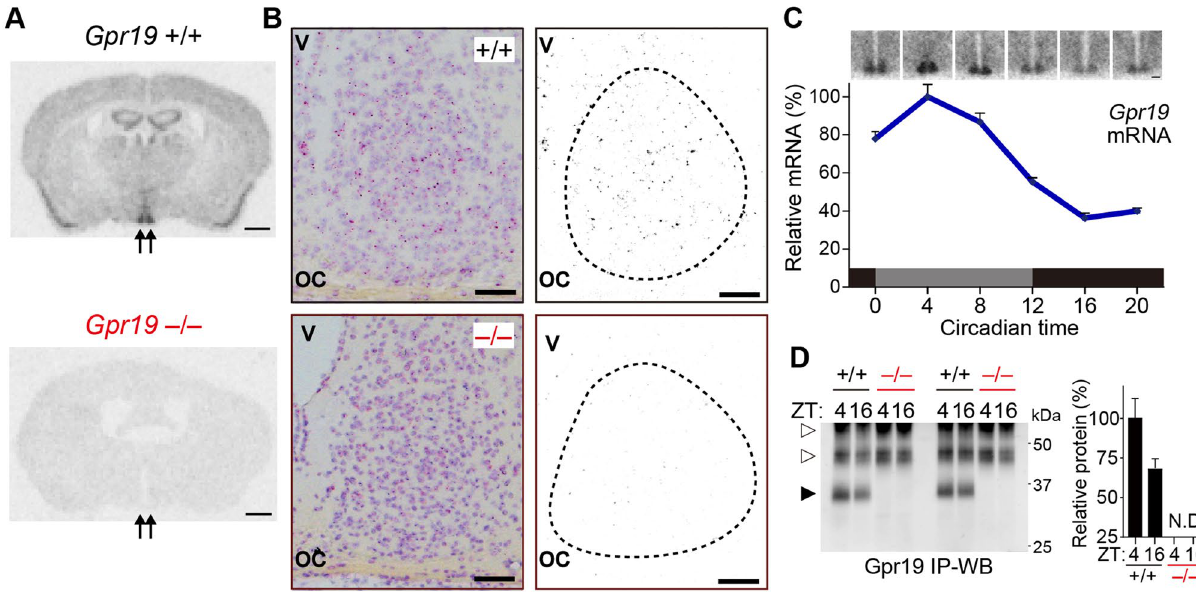
Figure 1. Spatiotemporal expression profile of Gpr19 in the SCN. ( A ) Representative brain coronal sections of Gpr19 +/+ and Gpr19 −/− mice hybridised to anti-sense 33 P-labelled Gpr19 riboprobe. Arrows indicate the position of the SCN. Scale bars, 1 mm. ( B ) RNAscope in situ hybridisation of Gpr19 in the SCN. The sections were counterstained with haematoxylin. Right panels show the extracts of the Gpr19 -RNAscope signal. The dashed lines delineate the SCN. oc, optic chiasm; v, third ventricle. Scale bars, 50 μm. ( C ) Circadian rhythm of Gpr19 expression in the SCN. Relative mRNA abundance was determined by in situ hybridisation autoradiography. Values are presented as the mean ± SEM ( n = 6, for each time point). Representative time-series autoradiographs are shown on top. Scale bars, 200 μm. ( D ) Western blots of Gpr19 in the SCN of Gpr19 +/+ and Gpr19 −/− mice at ZT4 and ZT16. Endogenous Gpr19 proteins were immunoprecipitated from hypothalamic SCN membrane extracts and probed for Gpr19. The solid and open arrowheads indicate Gpr19 and non-specific bands, respectively. Relative protein levels were determined by densitometry. P = 0.06, ZT4 vs. ZT16 in Gpr19 +/+ SCN samples ( n = 5), two-tailed Student’s t -test. N.D., not detectable, in Gpr19 −/−